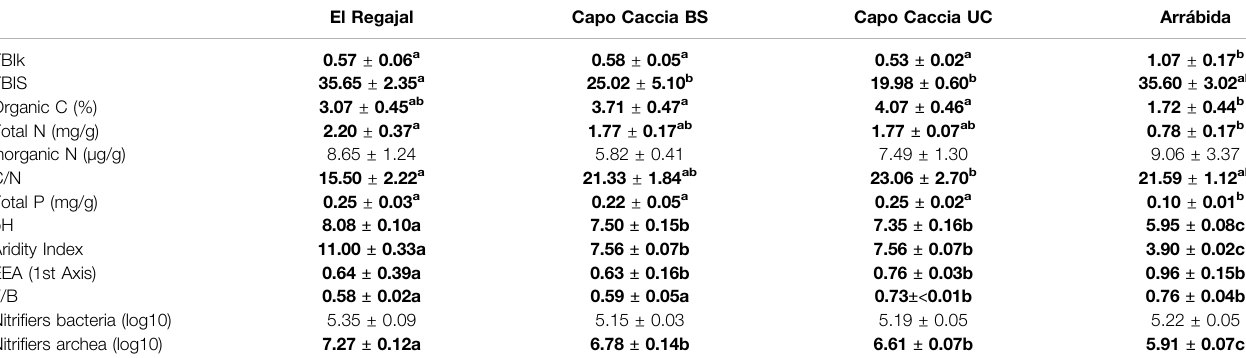
TABLE 2| Soilphysico-chemical andbiologicalpropertiesandotherstudiedvariablesinthetop8 cmofthesoilpro fi le(means ± SE)forthecontrolplotsinElRegajal(Spain, n (cid:2) 6),CapoCacciaBS(Italy, n (cid:2) 4),CapoCacciaUC(Italy, n (cid:2) 4)andArrábida(Portugal, n (cid:2) 3).BSandUCindicatebaresoilandundercanopymicrosites.Soilsampling wasperformedinApril2015.Statisticaldifferencesarehighlightedinbold,andlettersindicatesigni fi cantdifferences( p < 0.05)amongthecontrolplotsofthestudysites(one- way ANOVA, post hoc LSD test). TBIk, TBIS, EEA. TBIk, TBIS, and aridity index results were multiplied by 100.